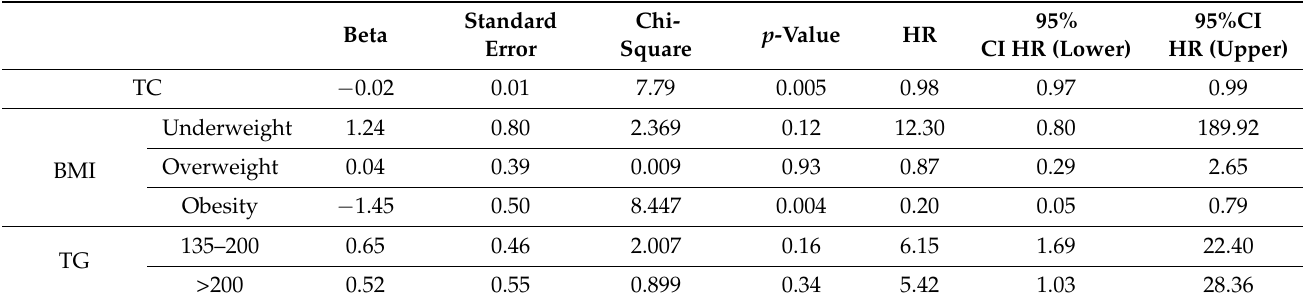
Table 9. The assessment of the influence of variables on mortality (Cox proportional hazards regression, multivariate